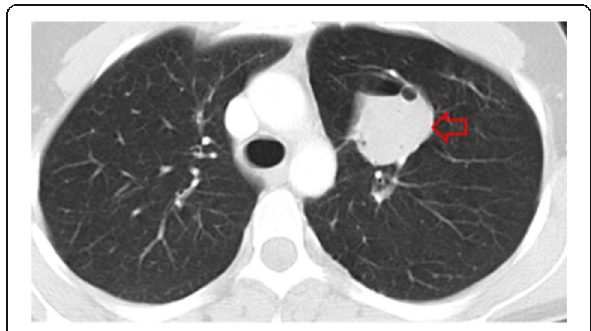
Fig. 10. Axial CT image shows an opacification with smooth contours, which is a pathologically proven bronchogenic cyst (red